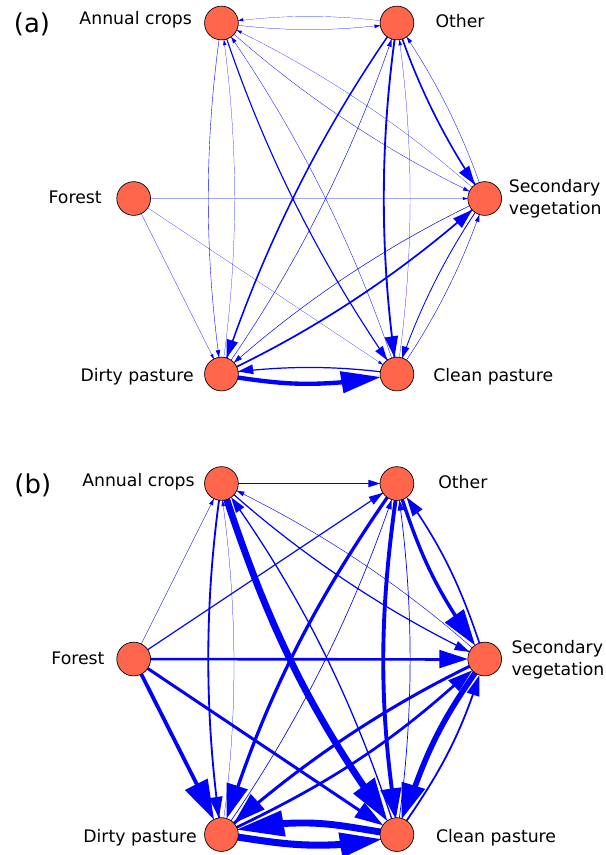
Figure 3. Illustration of the normalized transition matrices between simplified classes derived for the whole Brazilian Amazon from the TerraClass data set (changes between 2010 and 2012): (a) Markov transition matrix p (self-loops omitted) and (b) conditional transi- tion matrix q . The strengths of the arrows are scaled with the transi- tion probabilities except for those representing small values. Arrows with very small values (below 0.005) are not shown. The values are given in Tables S2 and